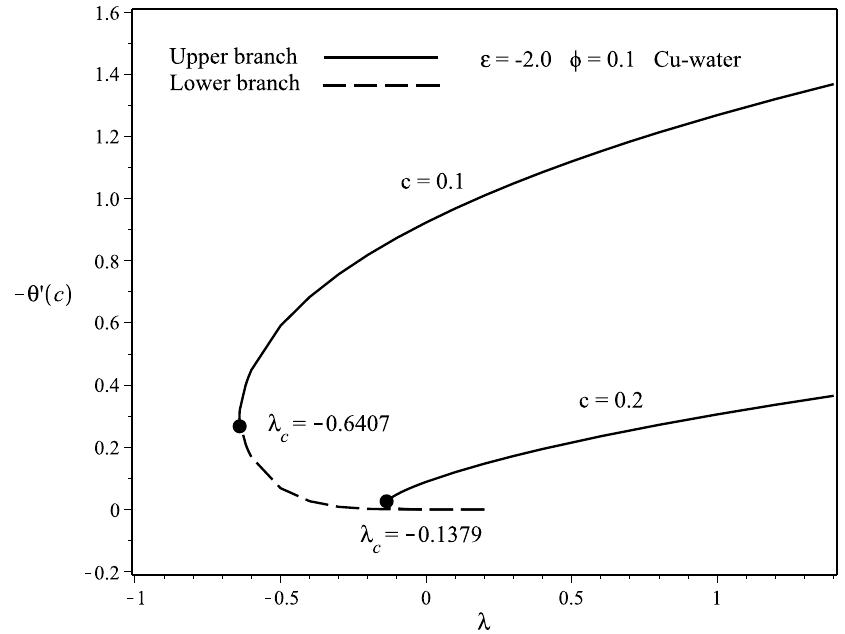
Figure 7. Effect of mixed convection parameter λ on the variation of local heat flux for different needle sizes c